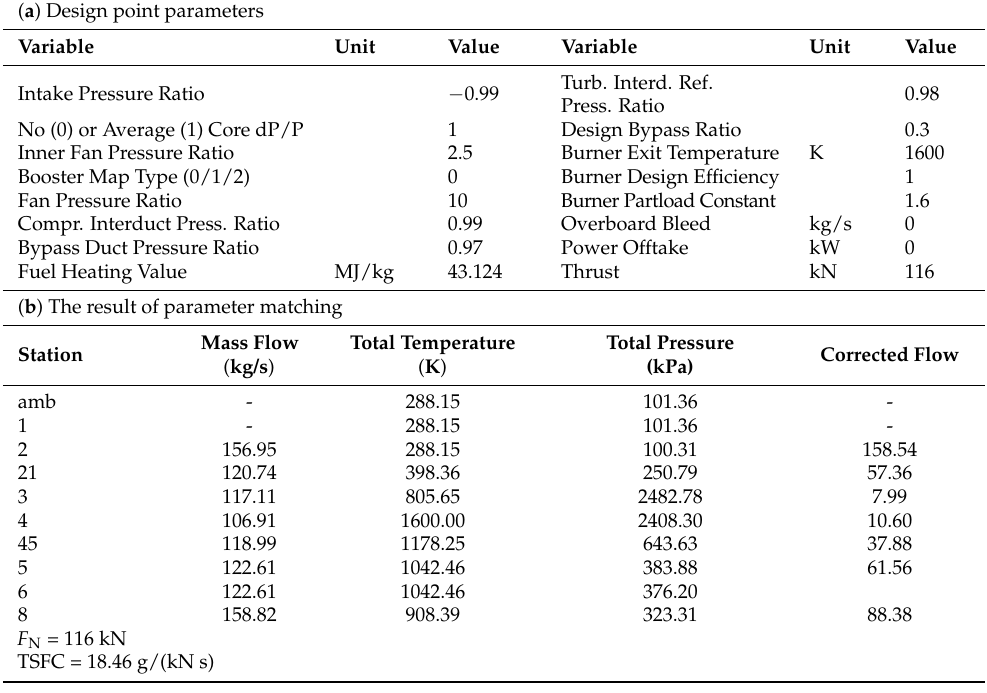
Table 2. The design point parameters matching